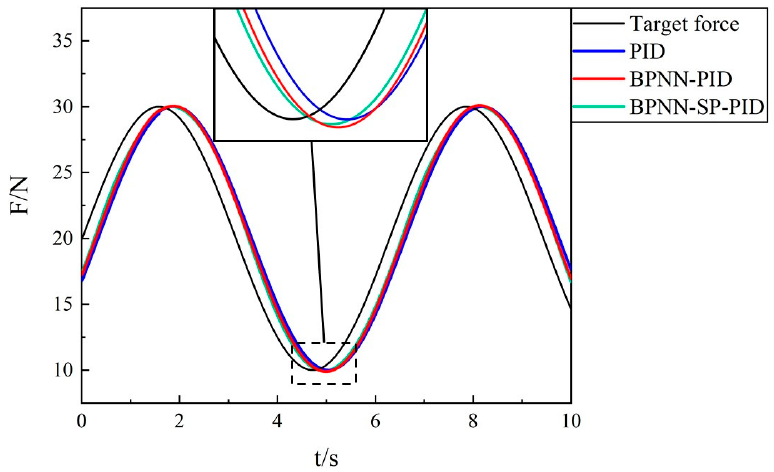
Figure 13. Comparison of sinusoid tracking response curves in the simulation.